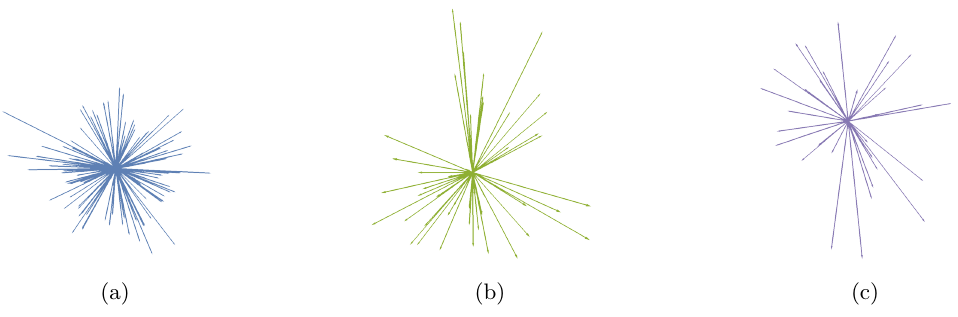
Figure 6 . Visualizations of a characteristic final state for (a) ν = 0 , (b) ν = 0 . 15 , and (c) equal to the mean in each distribution: (a) hI sph ν = 0 . 75 . The chosen events have I sph 192 (b) hI sph i = 0 . 26 , (c) hI sph i = 0 . 29 . For ease of viewing, all momenta with magnitude above the 192 192 average in the event are plotted, with the length proportional to the